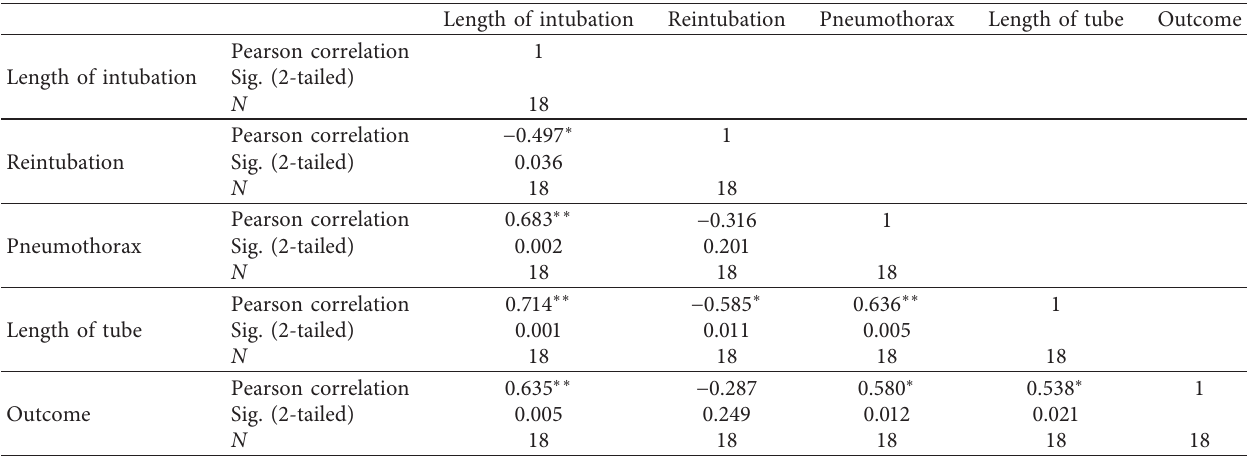
Table 3: Multivariate correlation of outcome, duration of ventilatory support, pneumothorax, reintubation, and duration of thoracostomy tube.